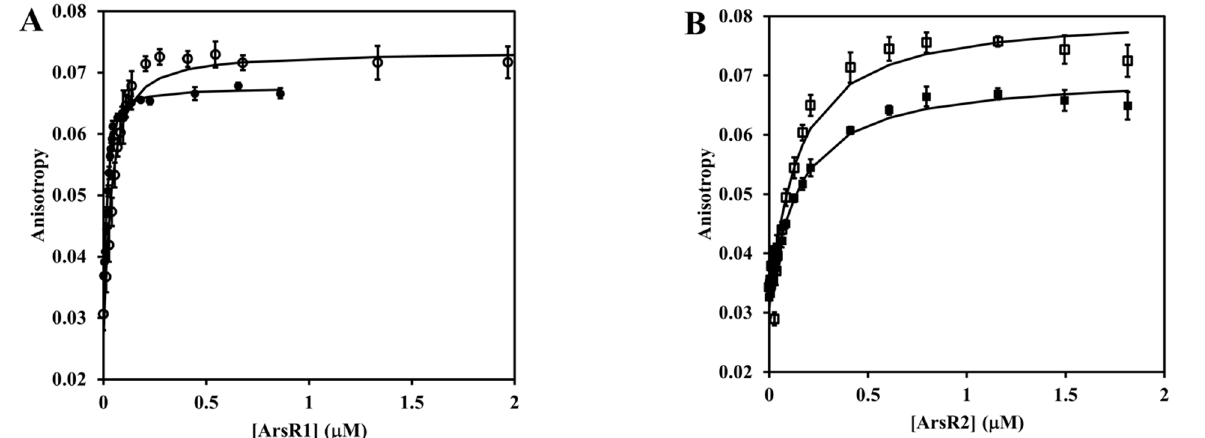
Figure 9. ArsR binding to DNA labelled by fluorescence probe. Titration was conducted in 10 mM MOPS/0.1 M NaCl/15% glycerol, pH 7.0 at 30 °C. Panel ( A ), 25 nM concentration of PDNA1 (•) or PDNA2 ( ◦ ) was titrated with the indicated concentrations of the recombinant protein ArsR1 protein. Panel ( B ), 25 nM concentration of PDNA1 ( ▫ ) or PDNA2 ( ▪ ) was titrated with the indicated concentrations of the recombinant ArsR2 protein. Solid lines represent the best fit of the data to Equation (5). The fitted parameters are presented in the main text. Each data point is a mean of ten determinations ± SD.